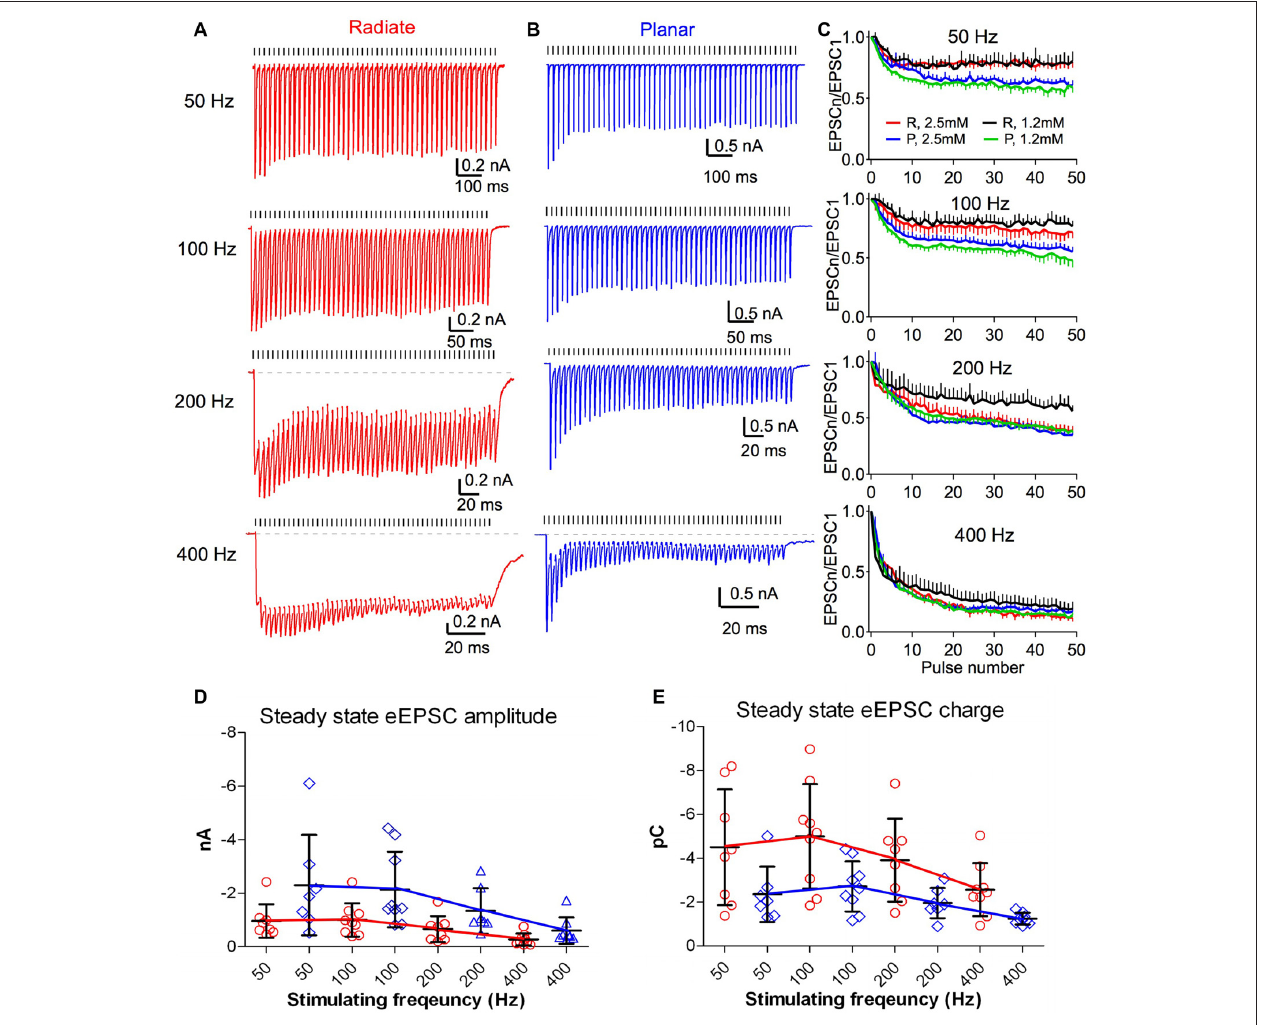
FIGURE 5 | Short term dynamics of auditory nerve synaptic inputs differs between radiate and planar cells. (A,B) Example eEPSC responses of a radiate cell (A) and a planar cell (B) to stimulus trains at different frequencies. Tick marks above the traces indicate the timing of the stimulus pulses. Dashed lines in the 200 Hz and 400 Hz trains mark the baseline of the EPSC responses. Color-coding applies to the entire figure (red: radiate; blue: planar). (C) Summary of the synaptic depression during stimulus trains at 50, 100, 200 and 400 Hz. EPSC n /EPSC 1 : all eEPSC sizes were normalized to the amplitude of the first eEPSC. Color traces in each panel showed recordings made under artificial cerebrospinal fluid (ACSF) containing either 2.5 mM Ca 2 + and 1.5 mM Mg 2 + (red and blue) or 1.2 mM Ca 2 + and 0.8 mM Mg 2 + (black and green). R: radiate neurons; P: planar neurons. (D) Summary of the average steady-state eEPSC amplitudes during the last 40 pulses of the stimulus trains in both cell types. Note that the plots are staggered to show the individual cells. (E) Summary of the average steady-state eEPSC charge during the last 40 pulses of the stimulus trains. Each symbol in (D,E) represents an individual